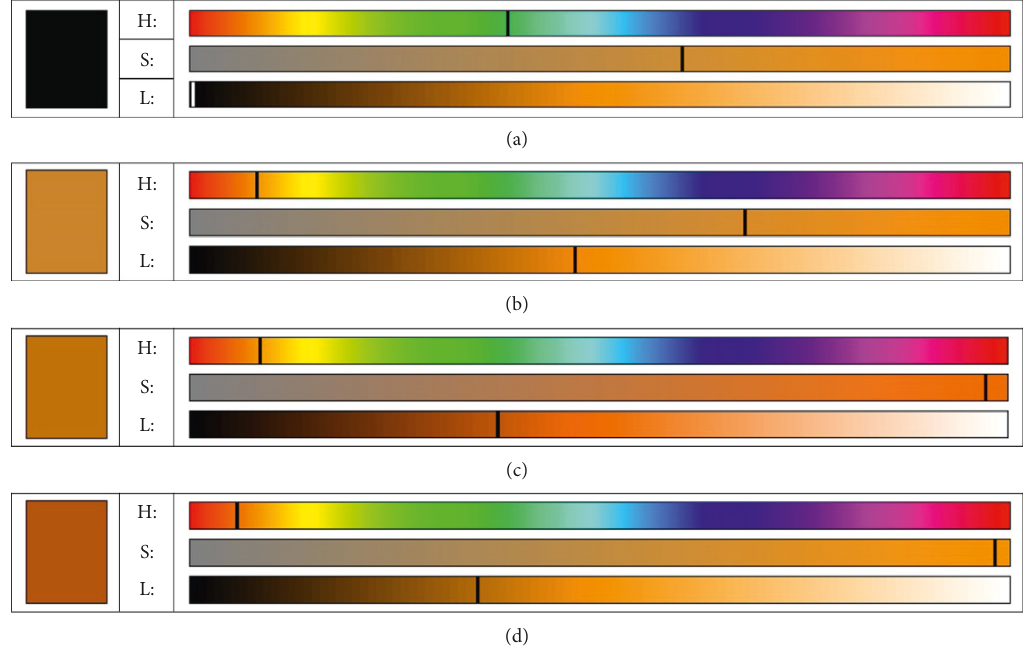
Figure 8: HSL colour model results: bitumen (a); unaged CSR (b); RTFO-aged CSR (c); PAV-aged CSR